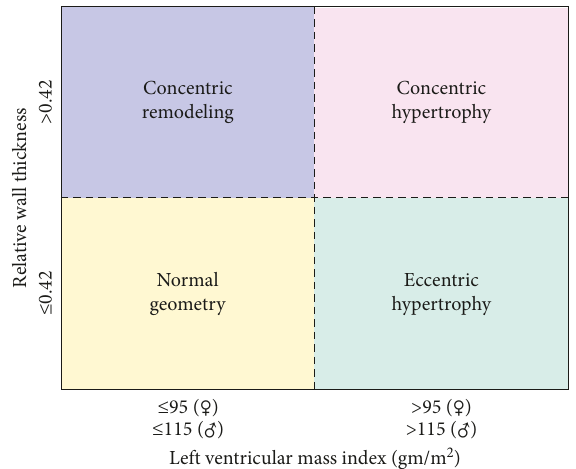
Figure 4: Characterization of left ventricular hypertrophy. The pa- tient’s ECG (Figure 2) suggests left ventricular hypertrophy. Trans- thoracic echocardiographic measurement of relative wall thickness ( relative wall thickness � ( 2 × posterior wall thickness ) / ( LVEDD )) coupled with left ventricular mass index can determine the specific type of hypertrophy. In the current case, the patient’s eccentric hy- pertrophy is consistent with volume overload secondary to a dilated cardiomyopathy (image from Lang RM. JASE. 2005; 18: